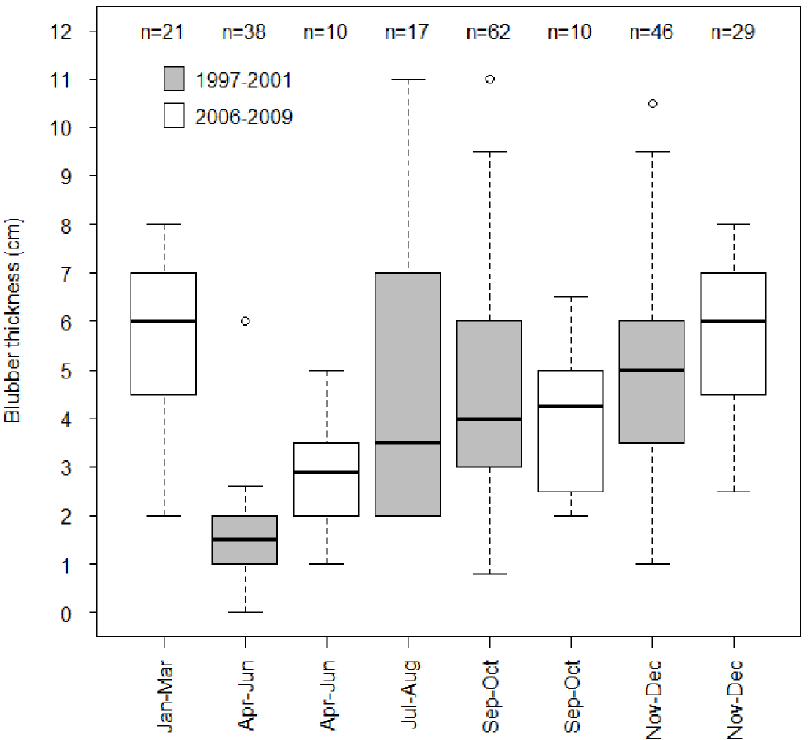
Figure 7. Boxplot of blubber thickness (cm) for Caspian seal carcases stranded 1997–2009, showing seasonal variation in body